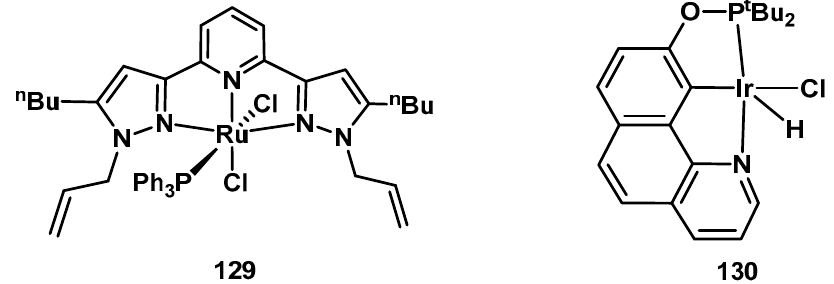
Figure 8. Ruthenium and iridium pincer catalysts reported by Thiel [815] and Huang [816] to catalyze transfer hydrogenations in the presence of ethanol.